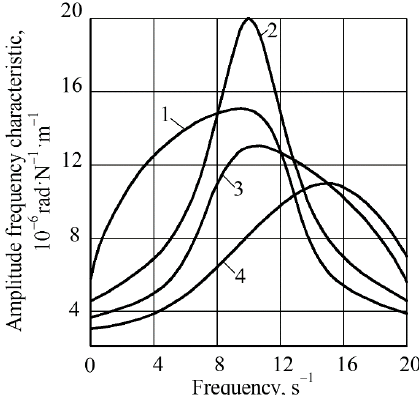
Figure 7. The amplitude–frequency characteristic of angle β during the processing of the disturbance impact by the technological module for different values of coefficient k с : 1—160 kN ∙ rad − 1 ; 2—210 kN ∙ rad − 1 ; 3—260 kN ∙ rad − 1 ; 4—310 kN ∙ rad − 1 .